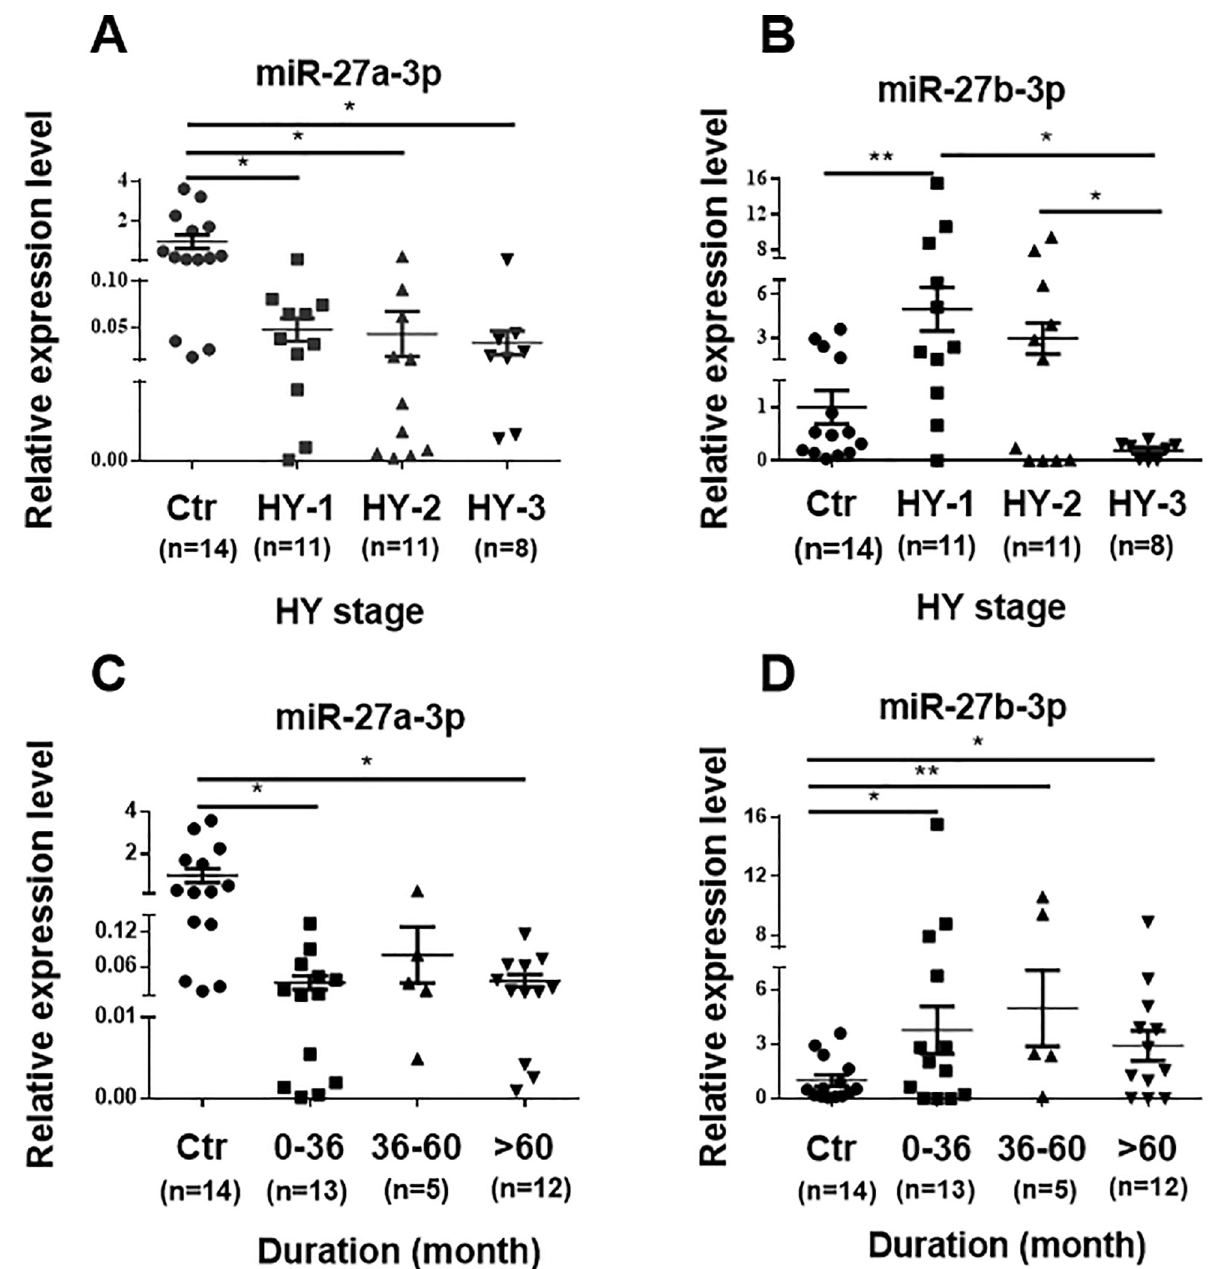
Fig 3. Correlation analysis of miR-27a/b-3p levels with disease severity and duration. (A) PBMCs derived miR-27a-3p level decreased along with the disease severity. (B) The expression of miR-27b-3p decreased with the disease severity, as was evidenced between HY-3 and HY-1 ( p = 0.015) or HY-2 ( p = 0.04) significantly. (C) Significant downregulation of miR-27a-3p expression with disease durations of 0–36 and > 60 months (D) Upregulation of miR-27b-3p independent to disease duration. Data are presented as means ± SEM. Differences were analyzed by one-way ANOVA in A, B, C and D. � p < 0.05, �� p < 0.001 and ��� p < 0.001. Ctr = Control; PD = Parkinson’s disease patients; HY =